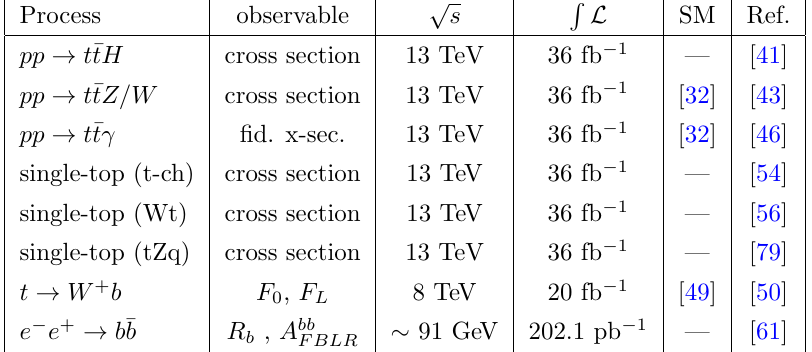
Table 1 . Measurements included in the EFT (cid:12)t of the top and bottom-quark EW sector. For each measurement, the process, the measured observable, the center-of-mass energy and the integrated luminosity are listed. The last column lists the references for the measurement that is included in the